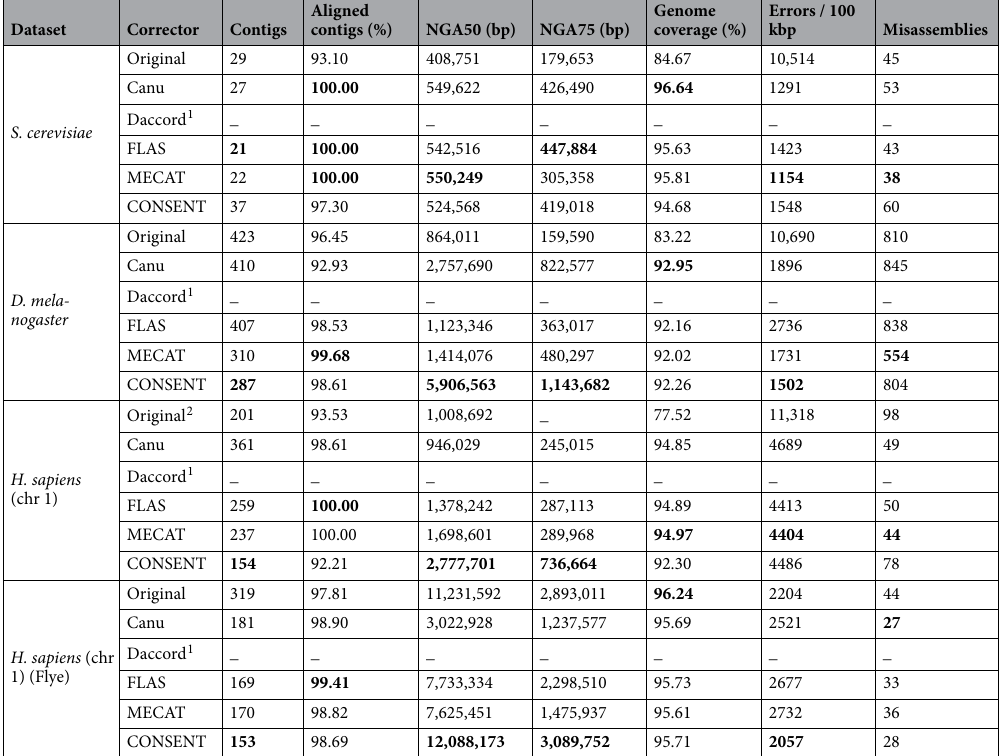
Table 3. Statistics of the assemblies generated from the raw and corrected real long reads. Best results for each metric is highlighted in bold. 1 As previously mentioned, Daccord results on the three datasets are absent, since it could not be run. 2 For the assembly of the original reads on the H. sapiens (chr 1) dataset, QUAST-LG did not provide a metric for the